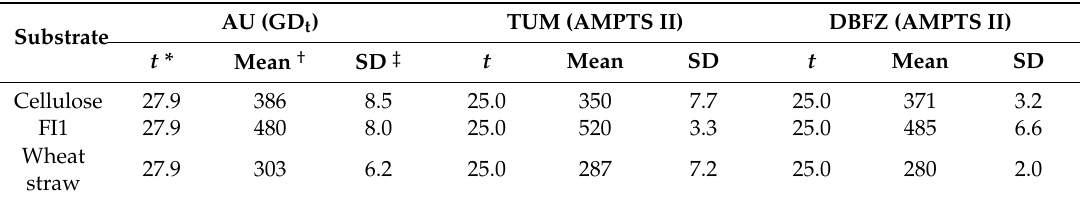
Table 5. Comparison of gas density (GD t ) and volumetric (AMPTS II) estimates of BMP (mL g − 1 ) for three substrates from Experiment 3, based on measurements made in three di ff erent laboratories (AU, TUM, and DBFZ). For all results n = 3 bottles per